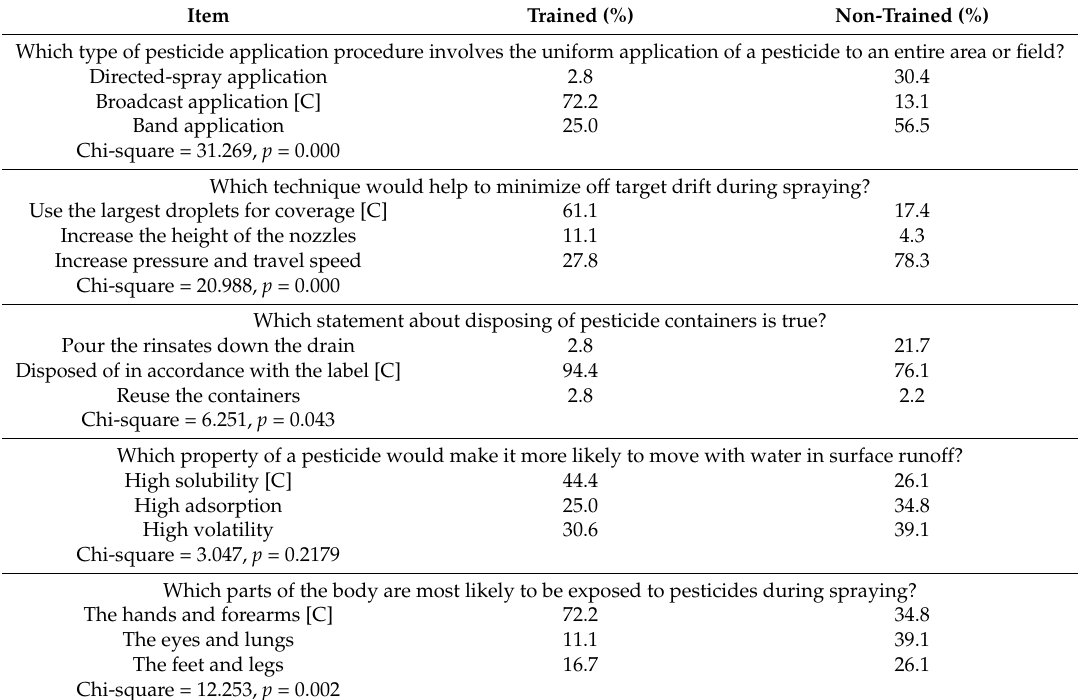
Table 2. Knowledge of pesticide use between trained and non-trained farmers. Item